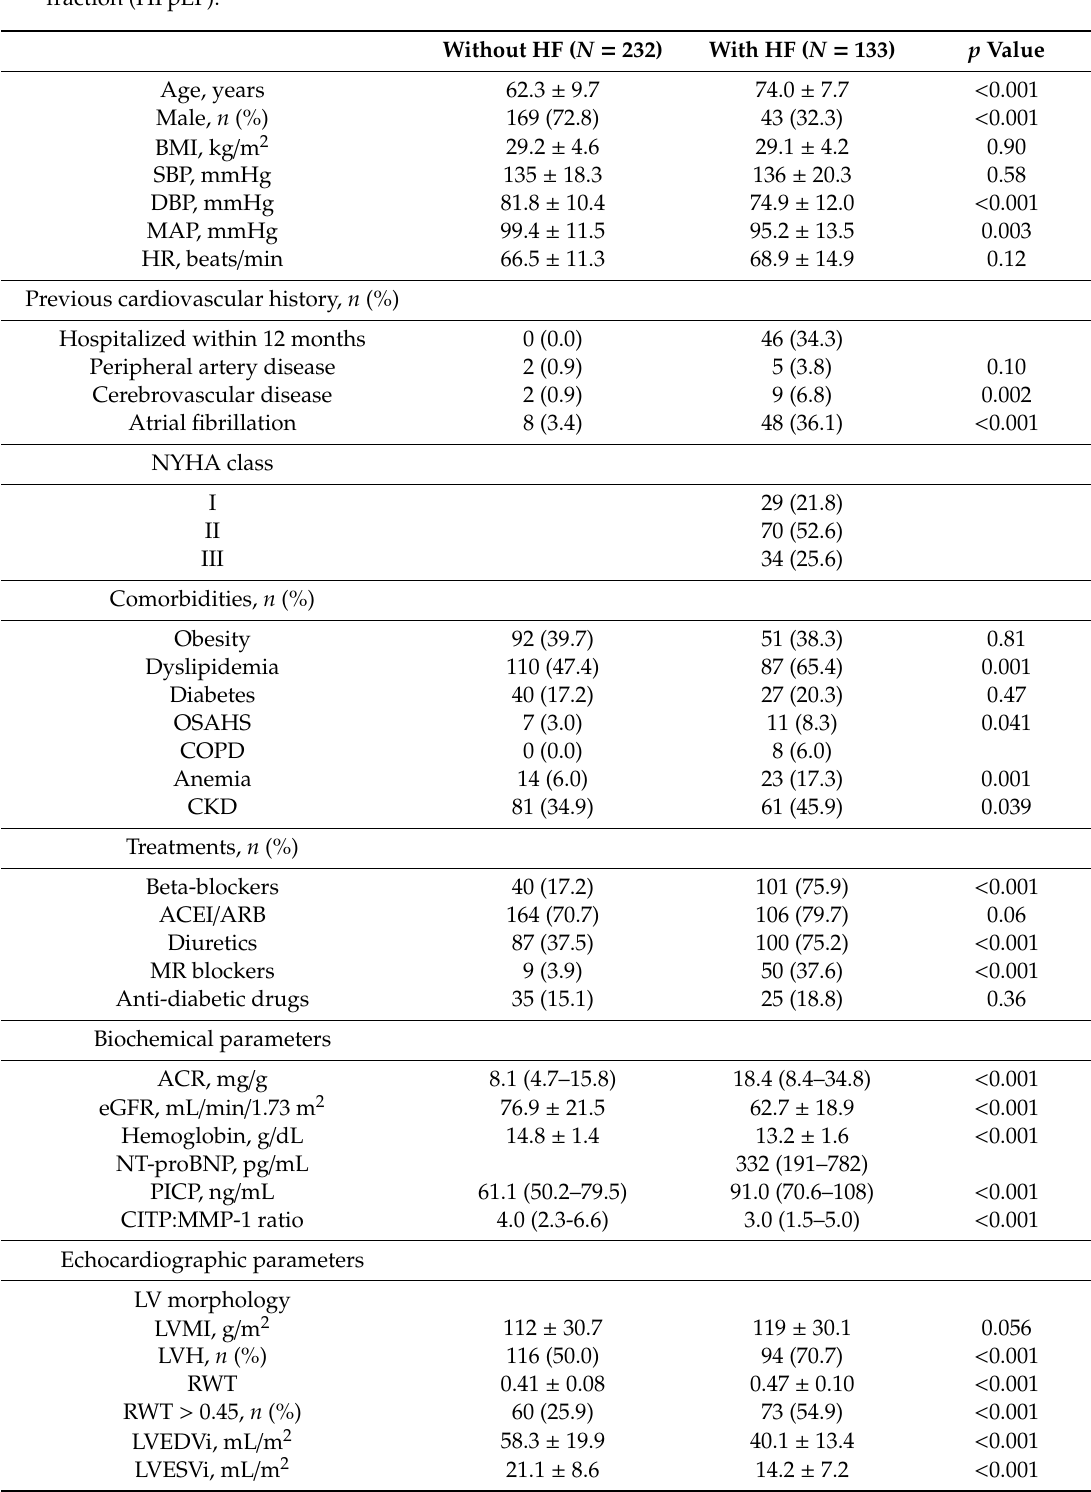
Table 1. Characteristics of patients classified according to the presence or absence of preserved ejection fraction